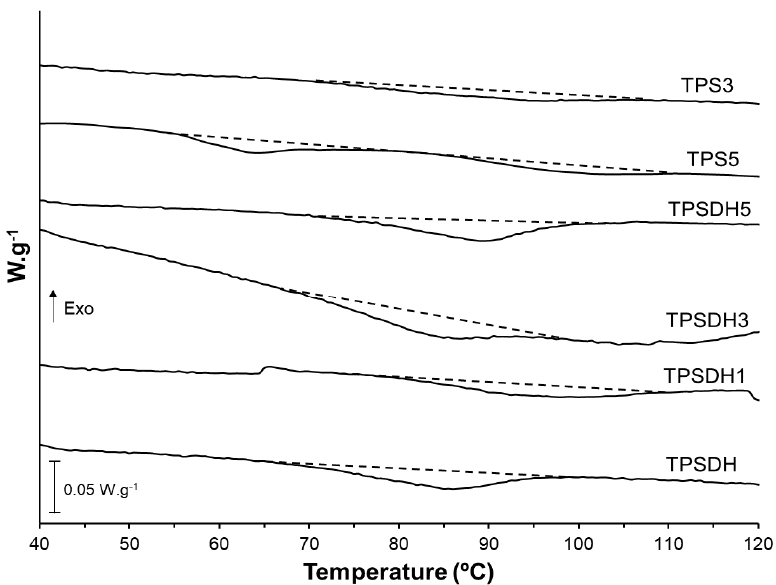
Figure 7. Differential scanning calorimetry (DSC) thermograms taken during first heating scan of thermoplastic starch (TPS) and TPS modified by dry heating (TPSDH) films with different contents of cellulose microfibers (CMFs).